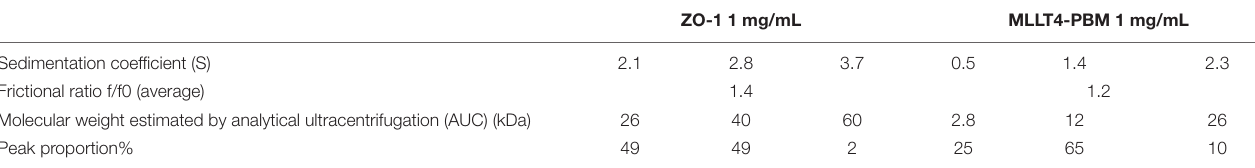
TABLE 4 | Hydrodynamic parameters of ZO-1 PDZ2 and MLLT4 PDZ derived from the analysis of analytical